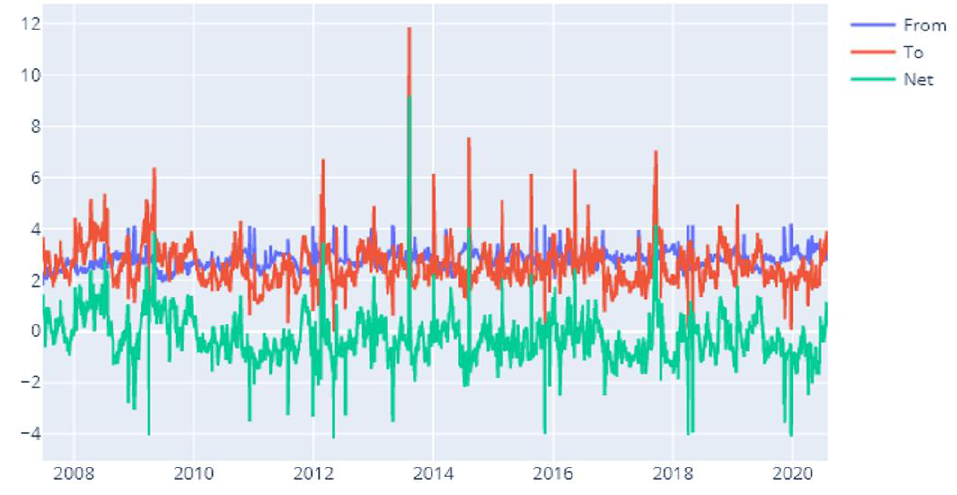
Figure 4. Entropy spillovers — CoVaR.